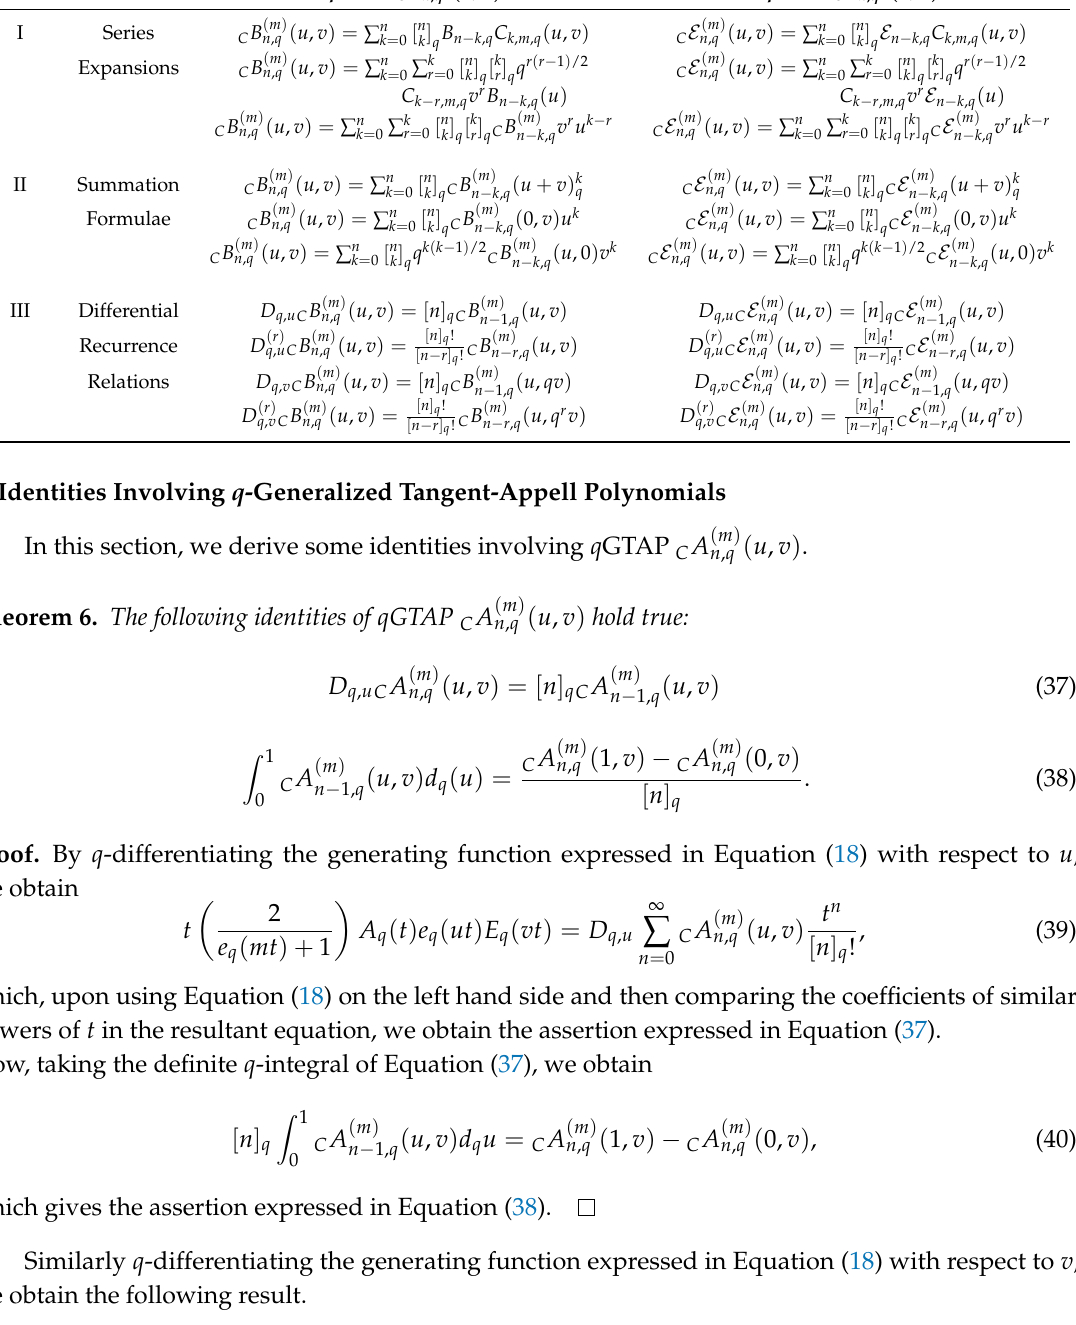
( m ) ( u , v ) and q GTEP n , q